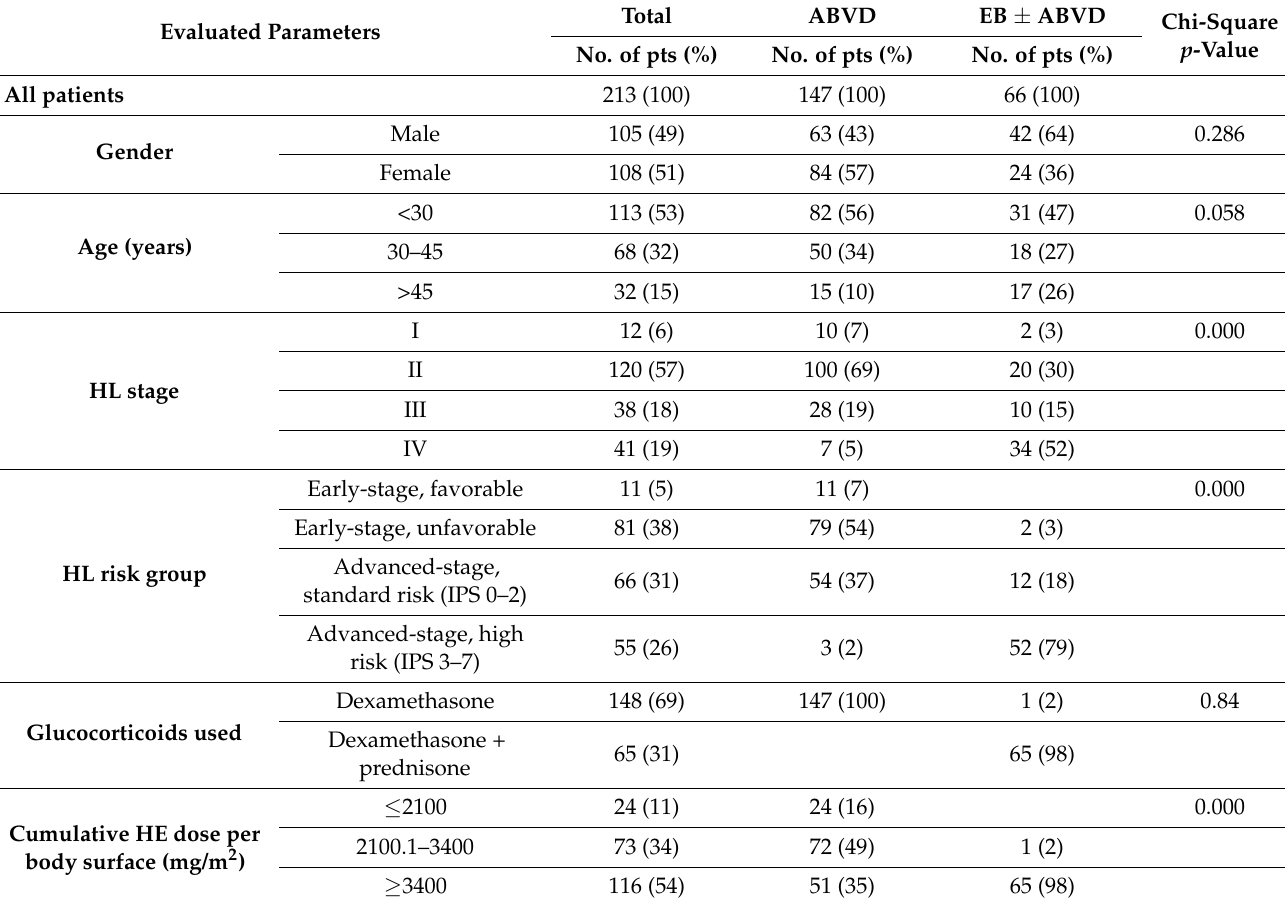
Table 1. Patient characteristics according to treatment protocols and BMD